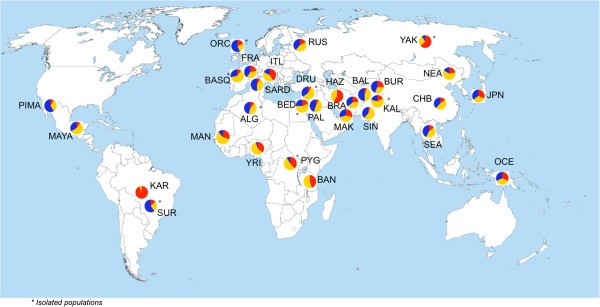
Global distribution of the genotype frequencies for the LCE3C_LCE3B CNV. The LCE3C_LCE3B-del is found in all the populations studied, mostly in the heterozygous state (yellow). The frequency of LCE3C_LCE3B-del in the homozygous state (blue) is higher in most non-Sub-Saharan African populations, with the exception of few ethnic groups. By contrast, the non-deletion homozygous state (red) tends to be more frequent in Sub-Saharan Africans, with the exception of few ethnic groups (KAR, ITL and YAK).